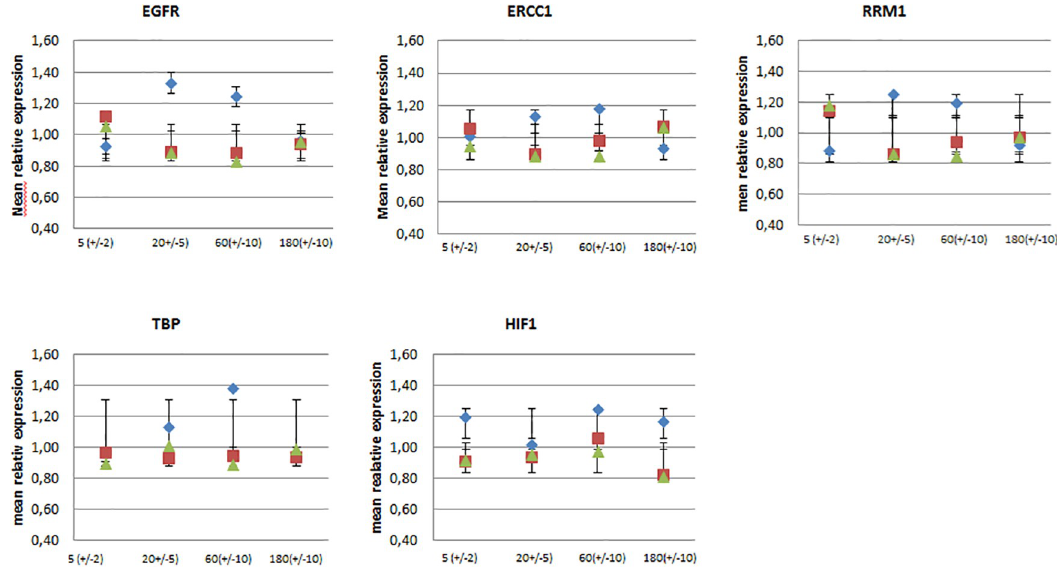
Fig 4. Mean relative expression values for different methods and times. Absolute copy numbers were normalized to mean copy numbers for each gene and patient. Mean relative values and standard deviations are shown for 4 different ischemic times and 3 methods (shock freezing in liquid nitrogen (blue), conservation in RNAlater for 1d (red) or 7d (green) before freezing). Absolute expression values can be depicted from S1 File.